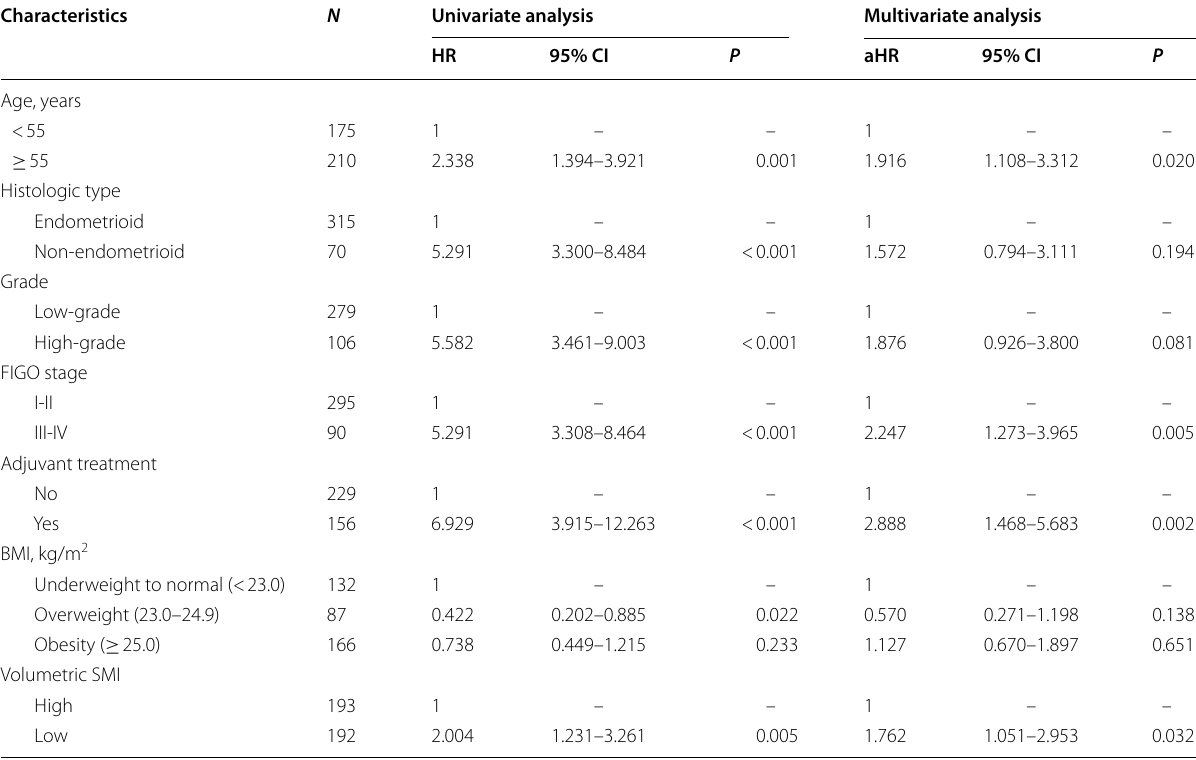
Table 3 Factors associated with patients’ progression‑free